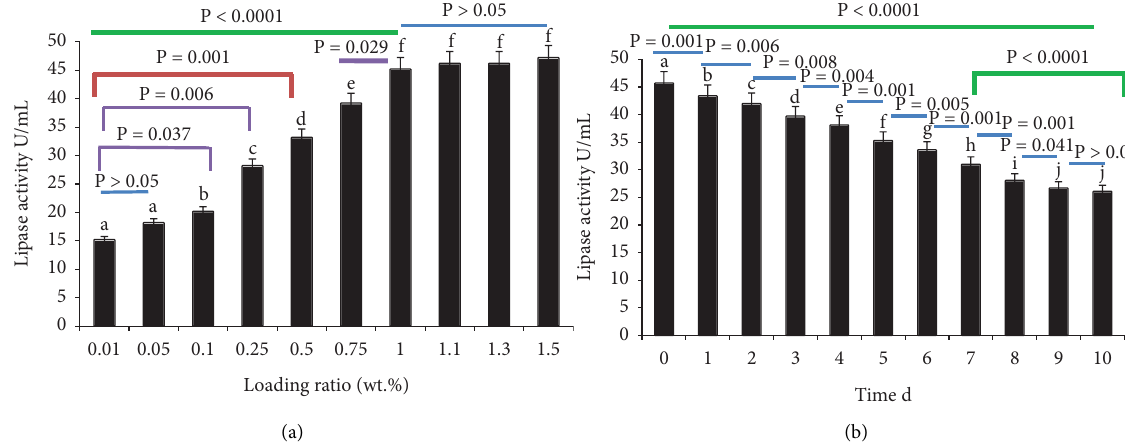
Figure 3: Efects of lipase loading (a) and vigorous shaking (b) on the prepared nanobiocatalyst E–NH